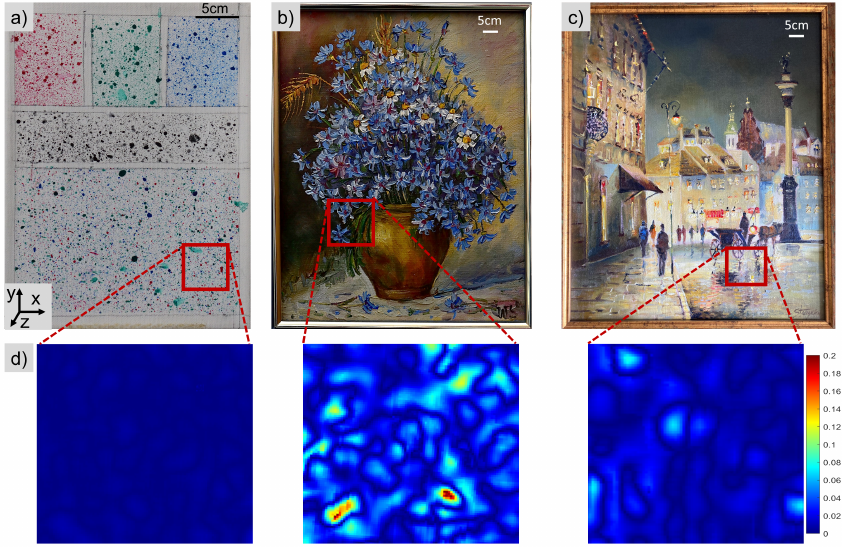
Figure 2. Samples ( a ) Mock-up with random artificial texture, and the oil paintings ( b ) Flower and ( c ) Street ; ( d ) the local maps of roughness in the example areas denoted at the samples with red